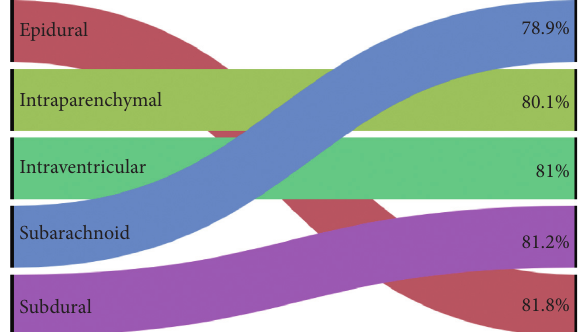
Figure 9: SVM classification